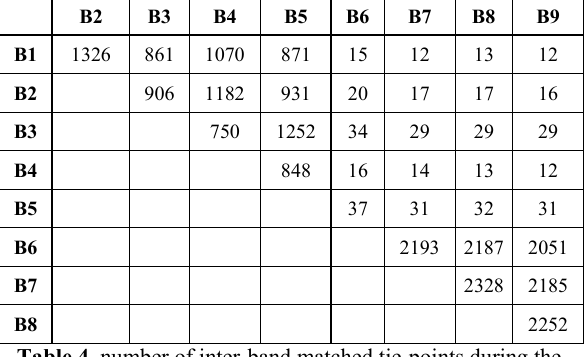
Table 4 . number of inter-band matched tie-points during the Metashape structure from motion process.